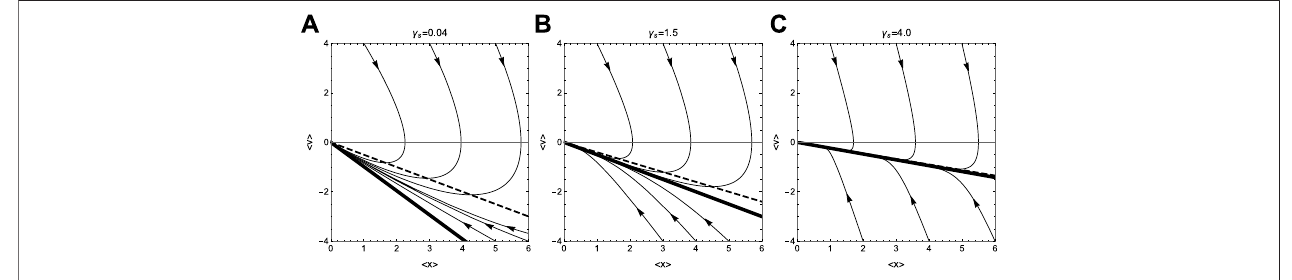
FIGURE1| BehaviorofthesolutionsoftheODEsystem( Eq.43 ),fordifferentinitialdata,with ω 0 =1andwith γ s =0.04 (A) , γ s =1.5 (B) and γ s =4 (C) .Thetinysolid lines correspond to individual trajectories, the thick solid lines denote the eigenvector u M and the dashed lines represent the solution obtained with the closure given in Eq. 50